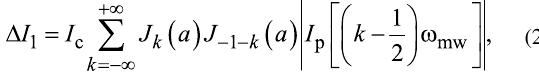
Figure 4: max Δ I 1 as function of F mw at various temperatures. The dotted lines mark the position of the two frequencies used in the exper-